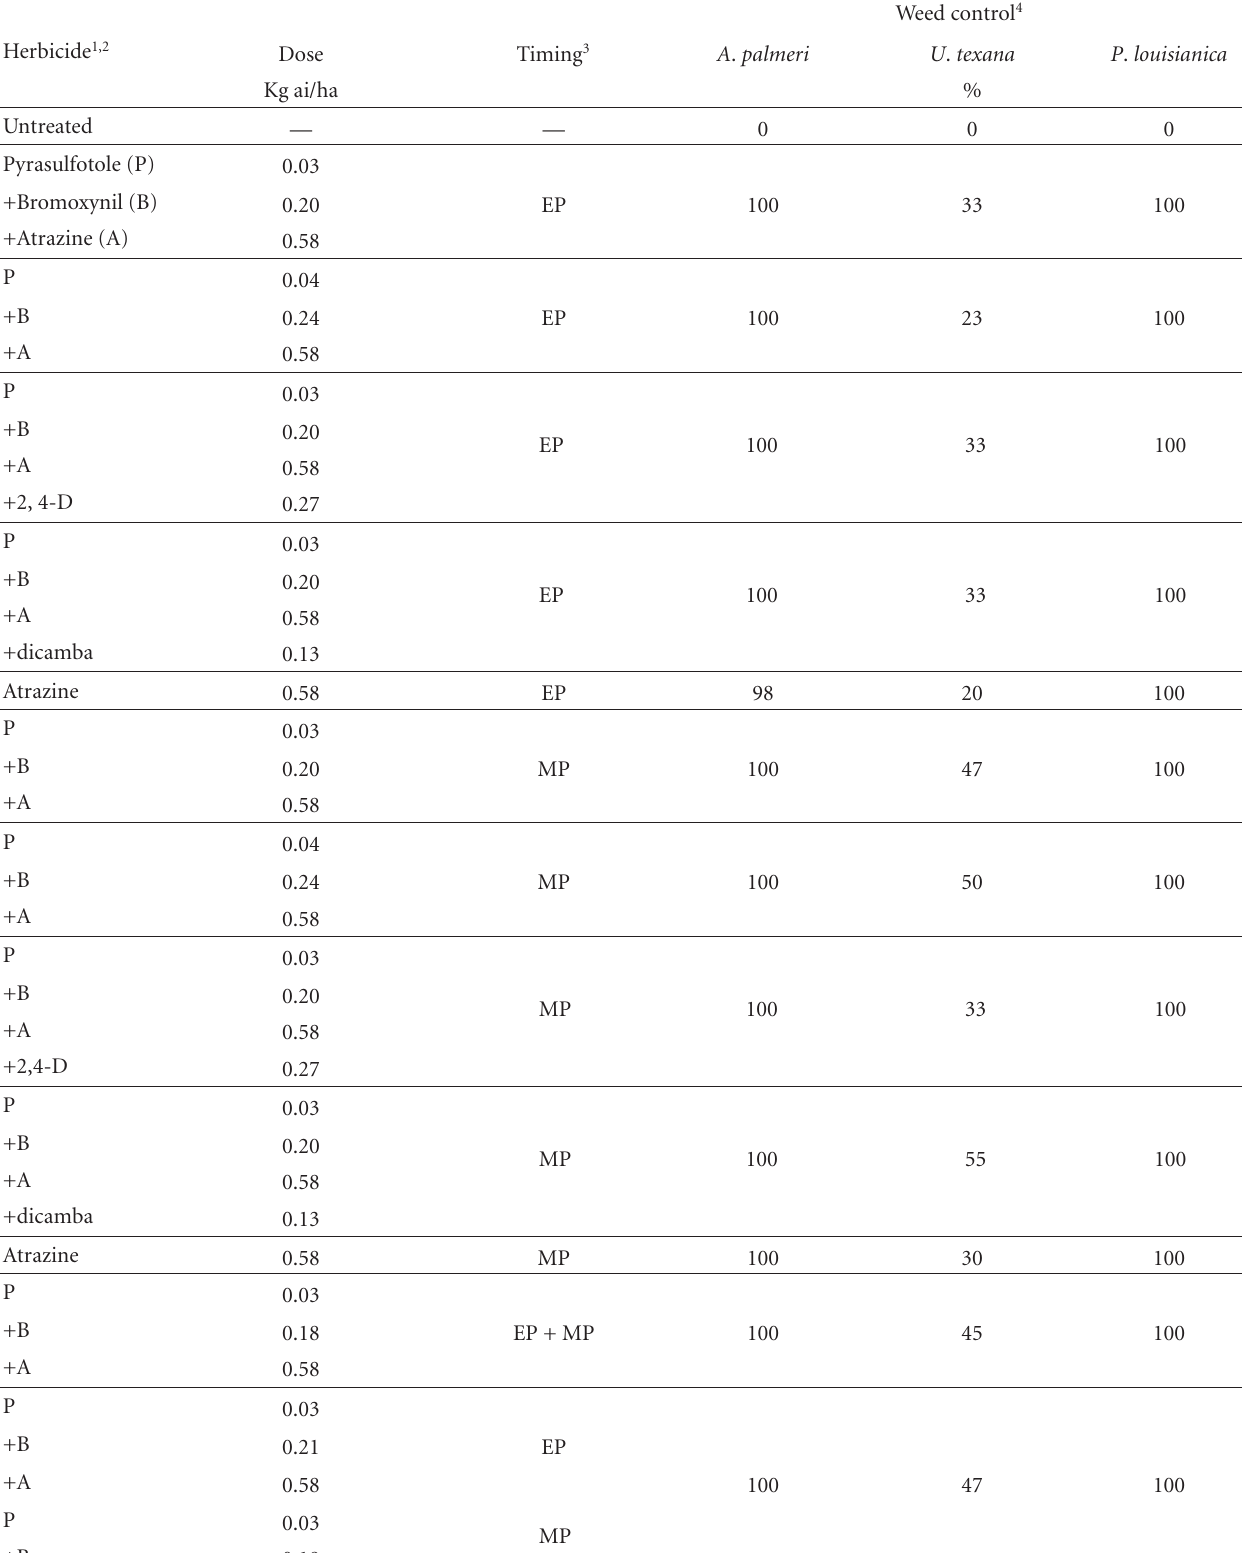
Table 1: Weed control at Lubbock and Yoakum as influenced by pyrasulfotole plus bromoxynil combinations in 2008, 4 weeks after MPOST